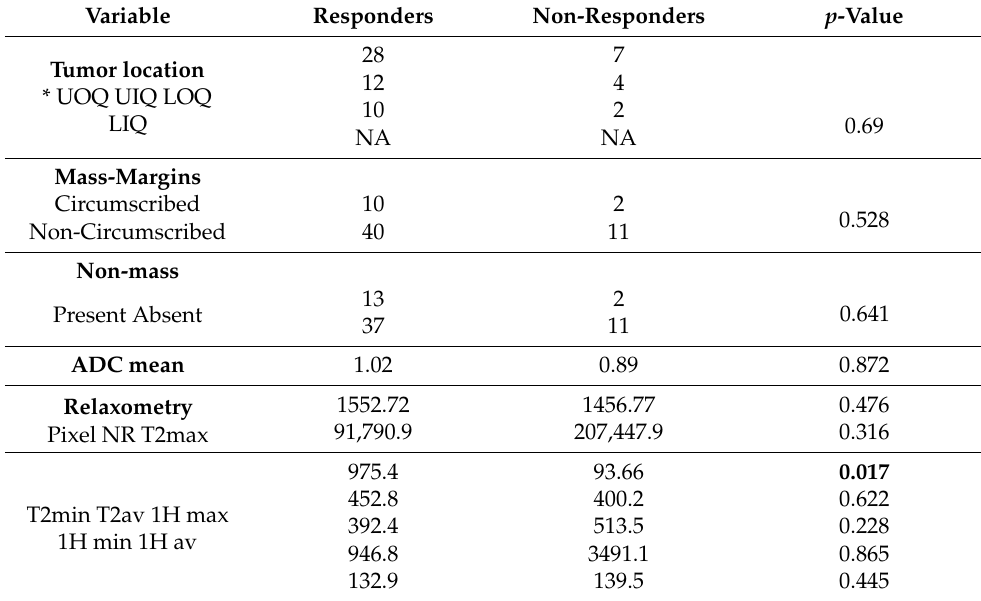
Table 2. MR relaxometry features of responders and non-responder